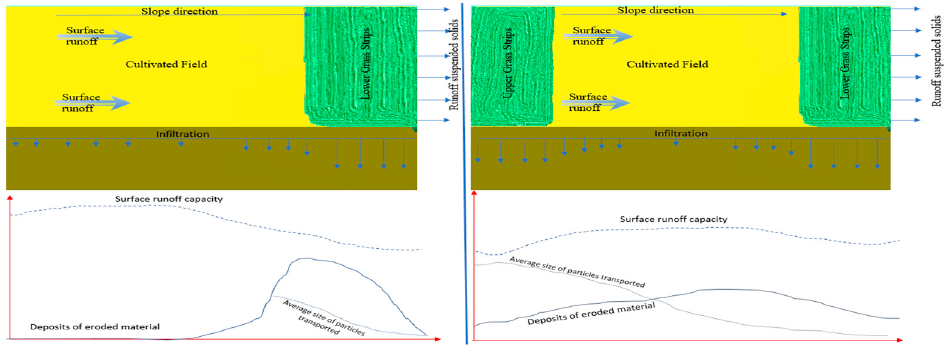
Figure 8. Schema of the field with 2 m grass strips on cultivable cropped land. Source: